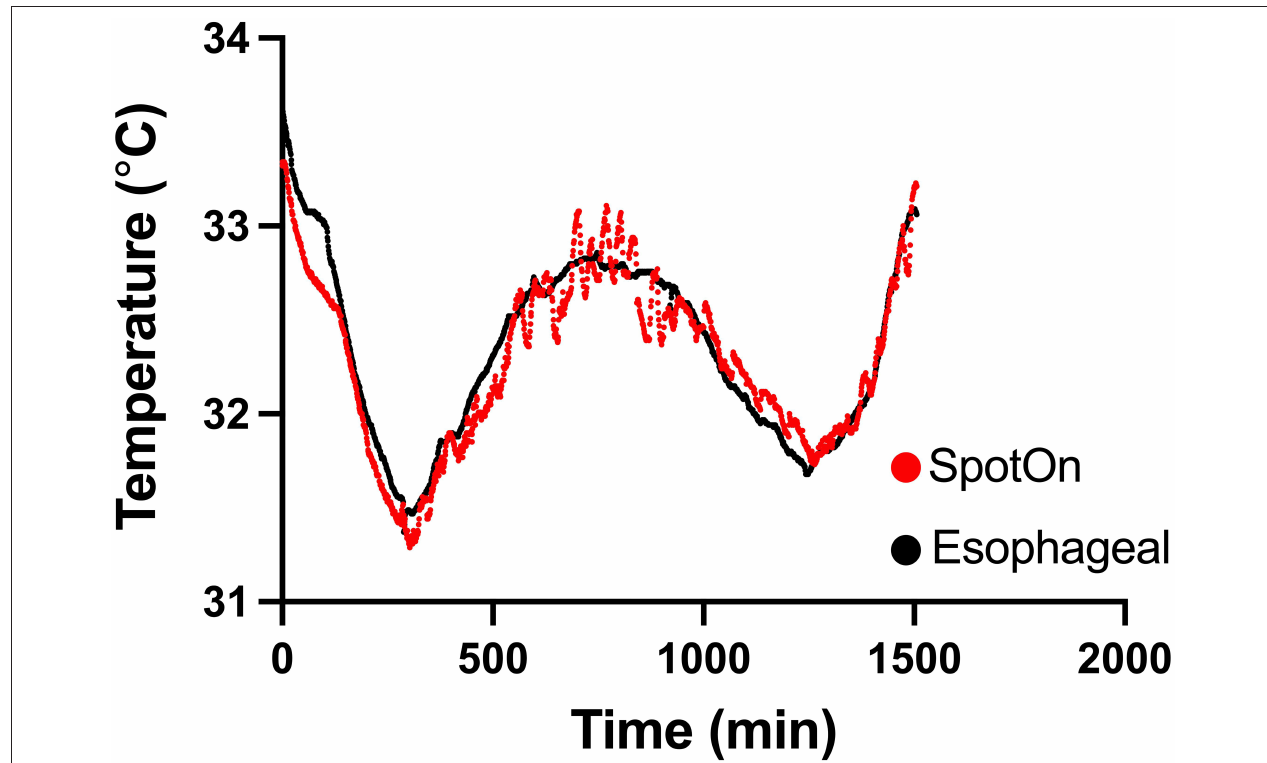
FIGURE 2 | Temperature measurement between SpotOn TM and an esophageal probe in a representative patient.